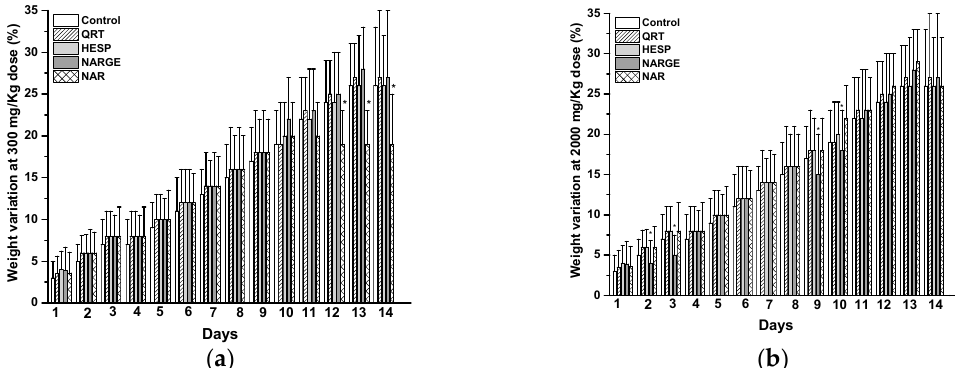
Figure 2. ( a ) Changes in body weight after treatment with control or quercetin (QRT), hesperidin (HESP), naringenin (NARGE), and naringin (NAR) at 300 mg/Kg dose, and ( b ) Changes in body weight after treatment with control or quercetin (QRT), hesperidin (HESP), naringenin (NARGE), and naringin (NAR) at 2000 mg/Kg dose. Results are presented as mean ± SE ( n = 3), * p < 0.05.